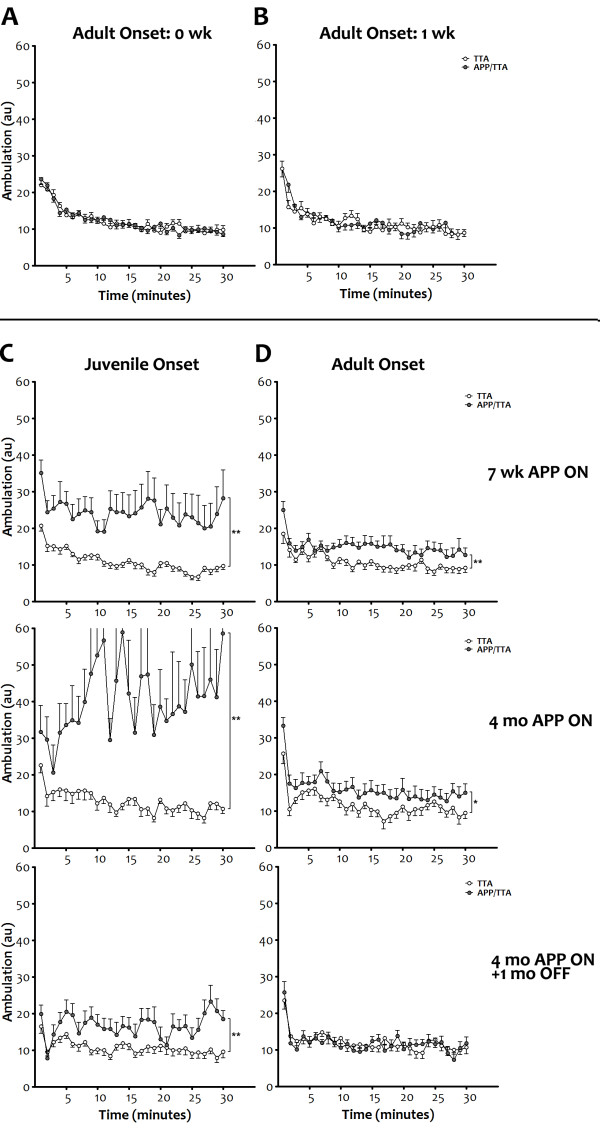
Juvenile onset of transgenic APP leads to significant motor hyperactivity that can be attenuated by delaying transgene expression. A, B Locomotion was measured using an infrared photobeam system to track activity over time. Activity was identical in control (TTA single-transgenic) and APP transgenic mice (APP/TTA double-transgenic) immediately prior to (0 wk, A; n = 21 TTA, n = 33 APP/TTA) and one wk after the induction of transgenic APP expression in adult-onset mice (1 wk, B; n = 18 TTA, n = 19 APP/TTA). C, D Hyperactivity was apparent after 7 wk of transgenic APP expression (top row) in both juvenile- (**p < 0.01; n = 23 TTA, n = 20 APP/TTA) and adult-onset mice (**p < 0.01, n = 19 TTA, n = 20 APP/TTA). Both juvenile- (**p < 0.01, n = 12 TTA, n = 8 APP/TTA) and adult-onset mice (*p < 0.05, n = 11 TTA, n = 15 APP/TTA) remain hyperactive with continued transgene expression, although the degree of variability and the magnitude of difference between control and APP transgenic animals is greater with earlier onset (middle row). Suppression of transgene expression for 1 mo after 4 mo of overexpression normalized ambulation levels in APP transgenic mice to that of controls following adult (p = 0.85; n = 15 TTA, n = 14 APP/TTA) but not juvenile-onset (**p < 0.01; n = 15 TTA, n = 13 APP/TTA; bottom row). au: arbitrary units.